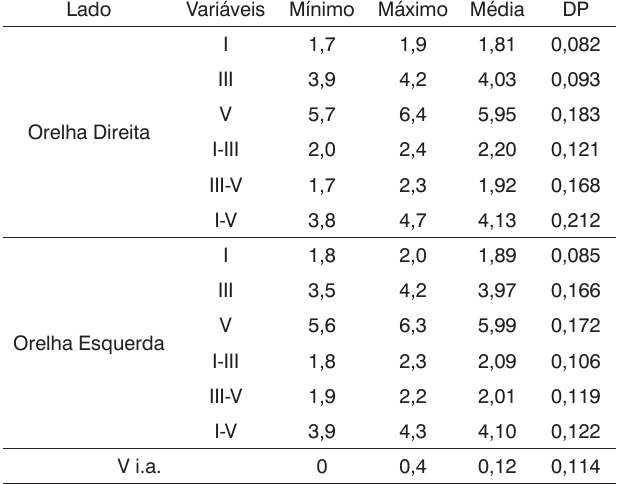
Tabela 3. Distribuição dos valores mínimos, máximos, médios e desvios-padrão das latências das ondas I, III e V e interpicos I-III, III-V e I-V entre as orelhas direita e esquerda no PEATE, dos pacientes com síndrome G/BBB.